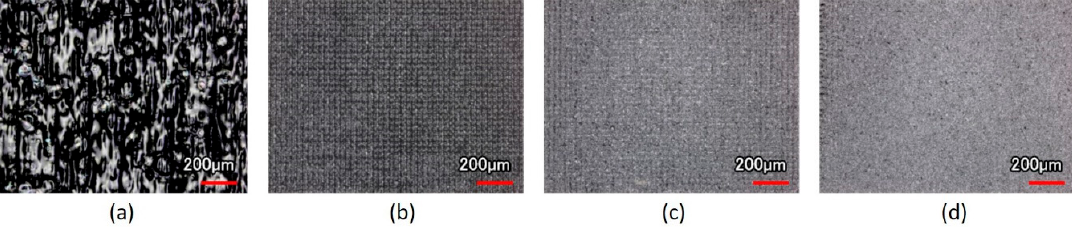
Figure 5. Optical images of the XO RGP contact lens treated with the laser system with line pitches of ( a ) 30 µ m and a scanning speed of ( a ) 500, ( b ) 1000, ( c ) 1500, and ( d ) 2000 mm / s.